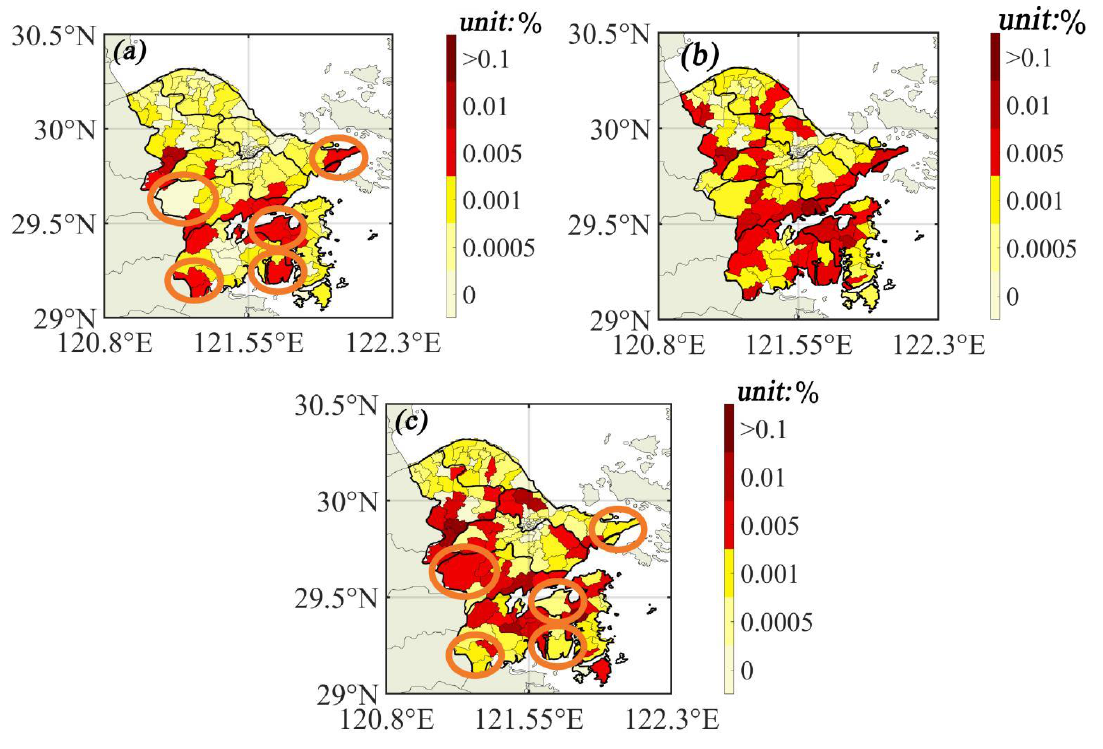
Figure 14. Average insured loss rate by township due to five typhoons in 2019. ( a ) Actual value; ( b ) RBF prediction; ( c ) BP prediction. Table 3. Average insured loss rates in 2019 for rural housing in the most severely affected town- ships.